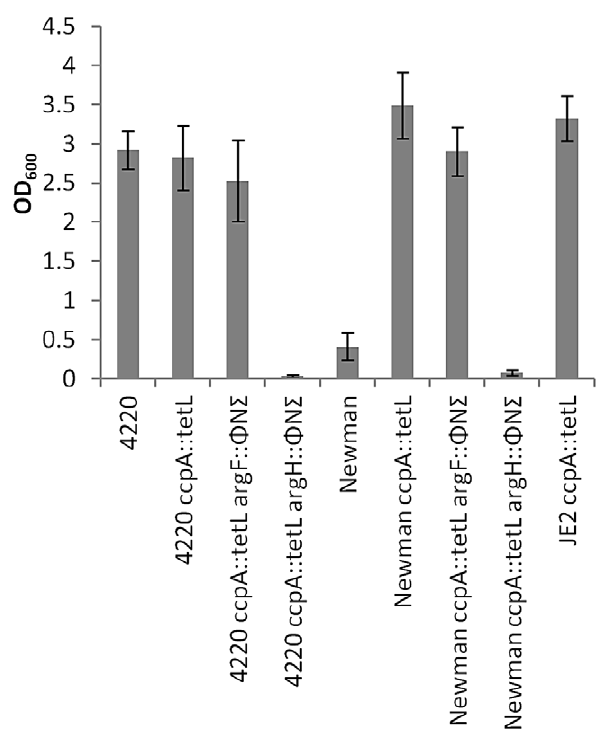
Figure 7. Determination of arginine biosynthesis-dependent genes in S.aureus Newman and RN4220. Defined bursa aurealis transposon mutants in argF and argH were transduced into Newman ccpA::tetL and RN4220 ccpA::tetL and assessed for growth in CDM-R for 18 hours. Data represent means 6 SEM of three independent experiments.